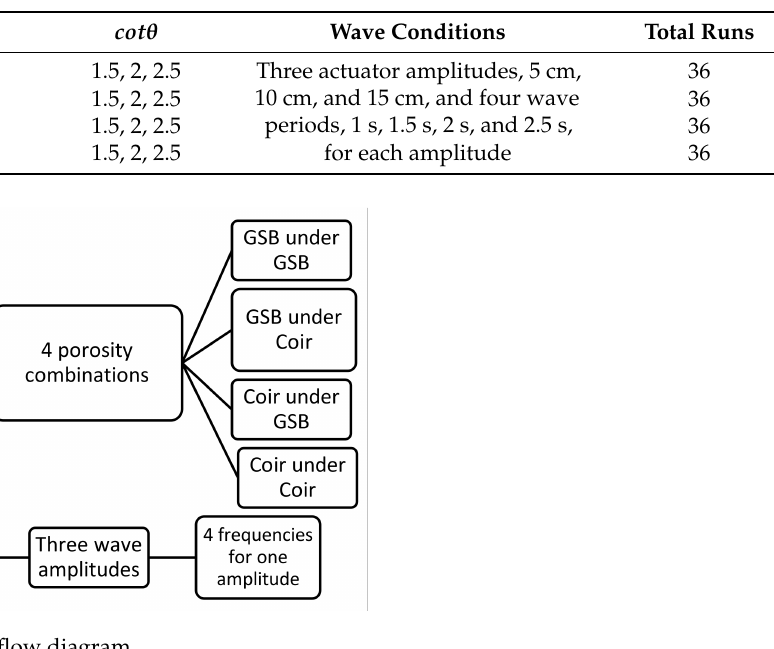
Table 5. Experimentation program.